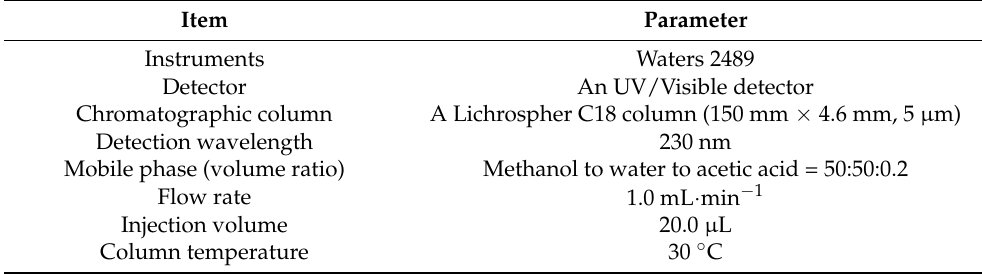
Table 1. The HPLC instrument configuration and chromatographic